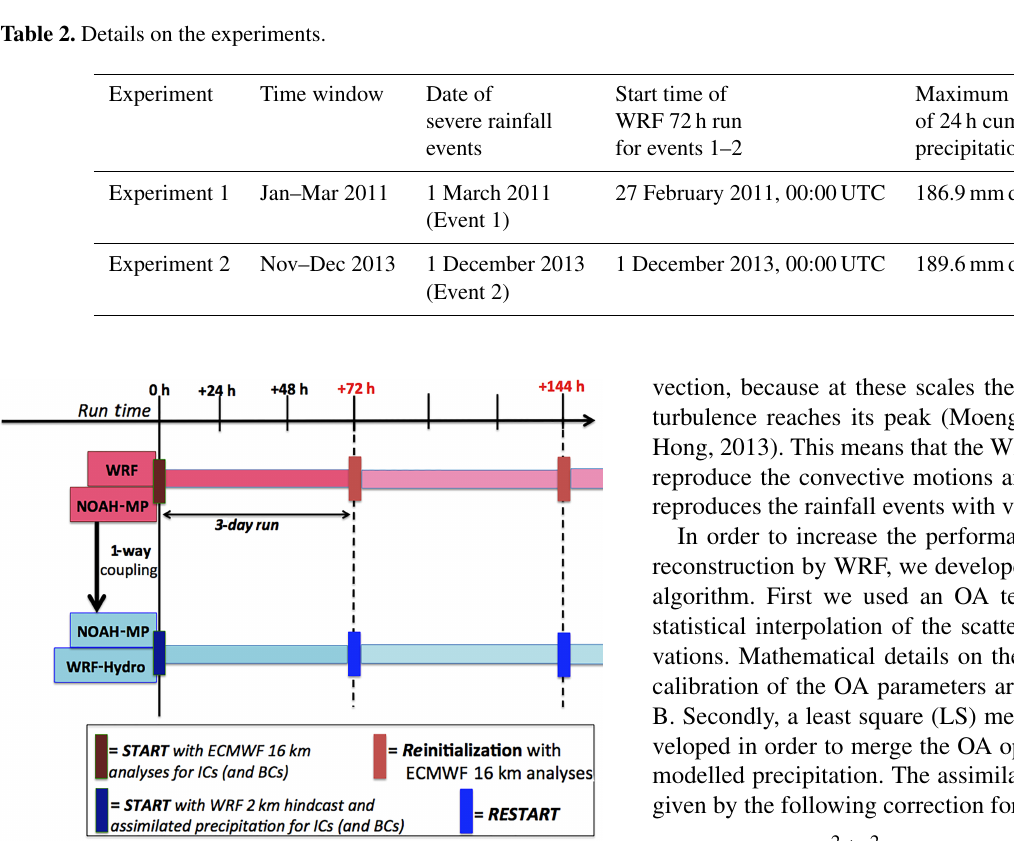
The hydraulics component of WRF-Hydro system is ini- tialised with the NOAH MP overland and subsurface water flows that are dry at the initial time. Thus a spin-up period is required to laterally route the groundwater of the basin and to allow the river network to reach a steady state. Senatore et al. (2015) considered monthly spin-up for evaluating the WRF-Hydro results and we decided to follow the same strat-